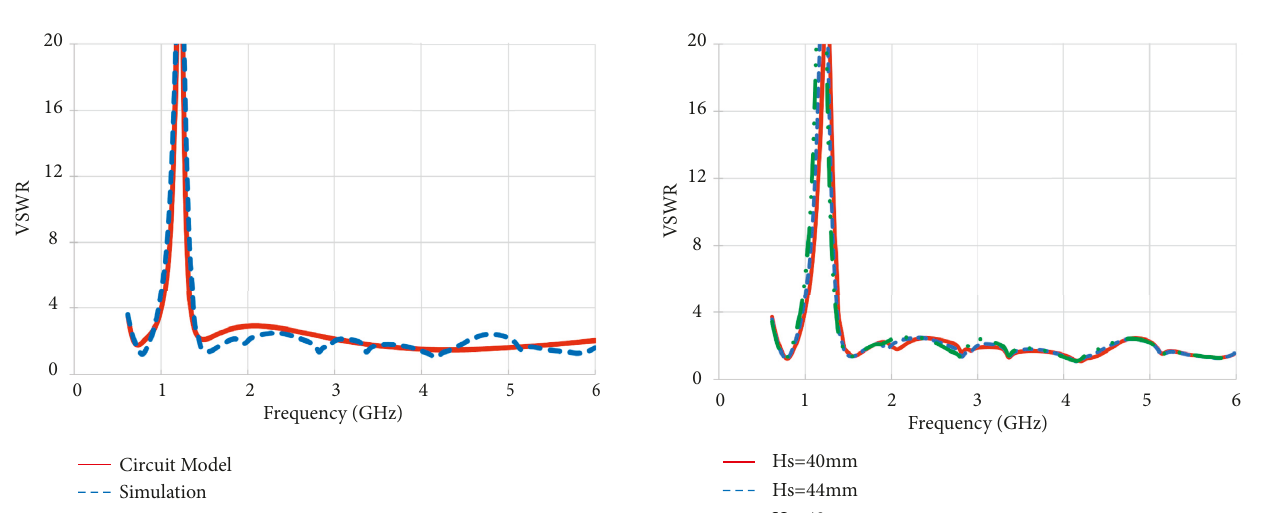
Figure 4: Simulated and circuit model driven VSWR of the antenna.